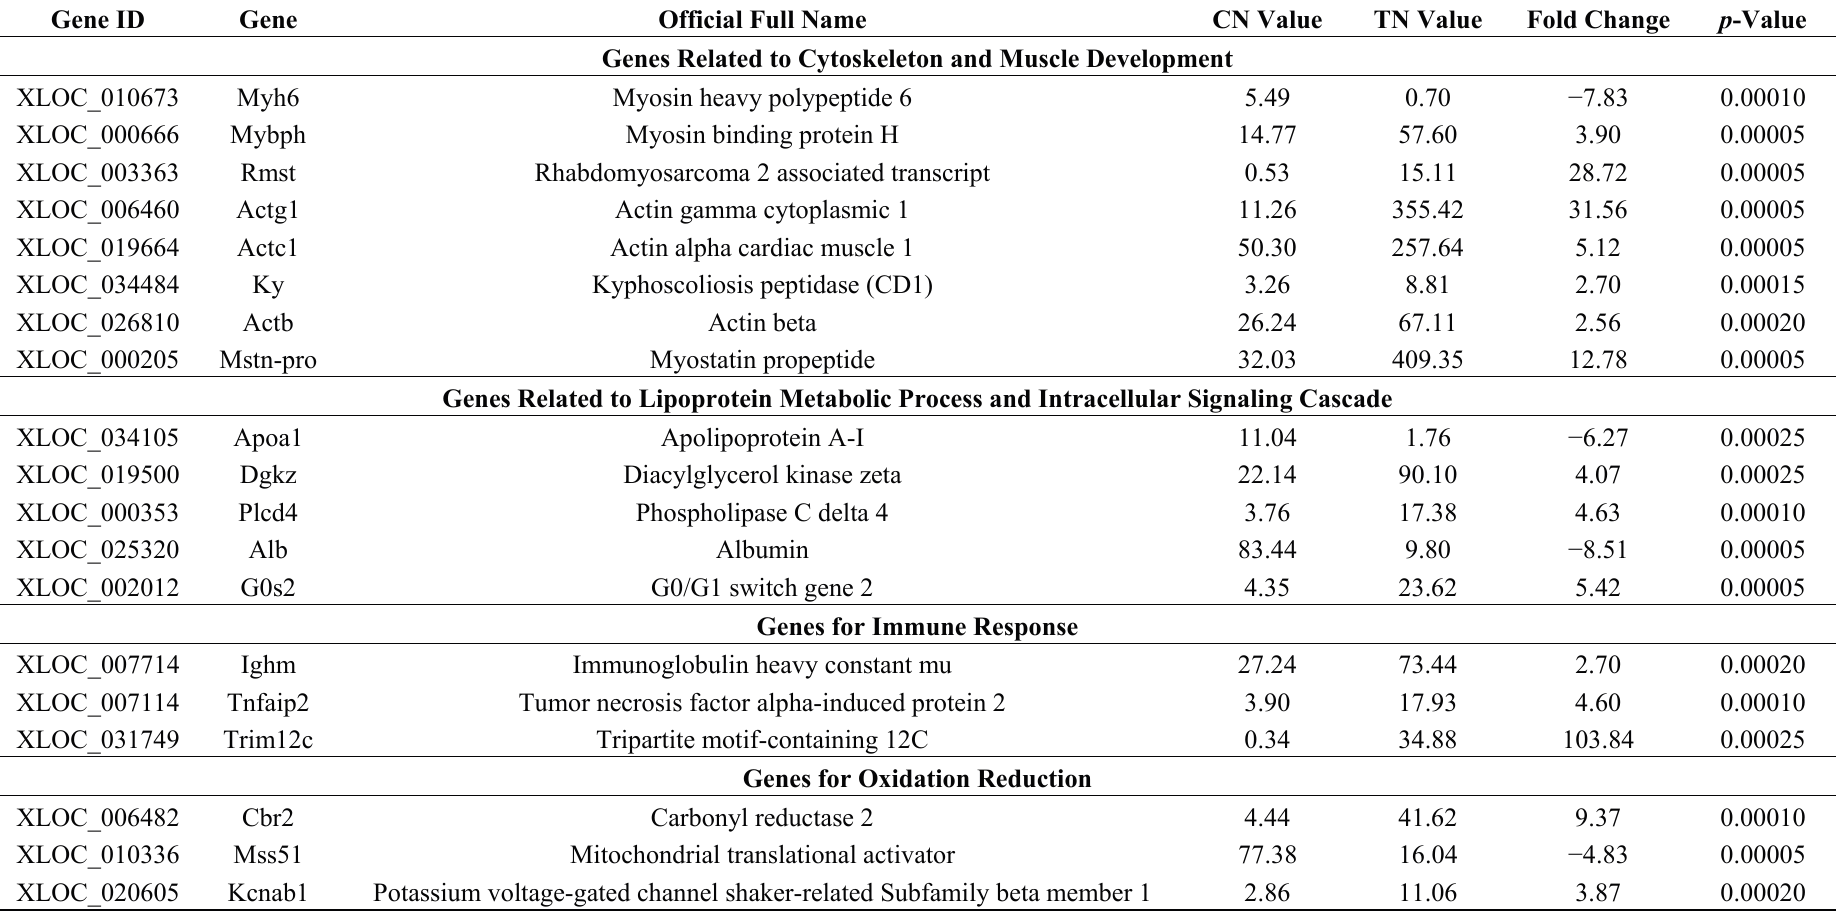
Table 3. Differentially expressed genes between myostatin propeptide transgenic and littermate control mice. (FPKM ≥ 5; fold change ≥ 2). inf represent the fold change cannot be calculated because the expression level was not detectable in wild-type